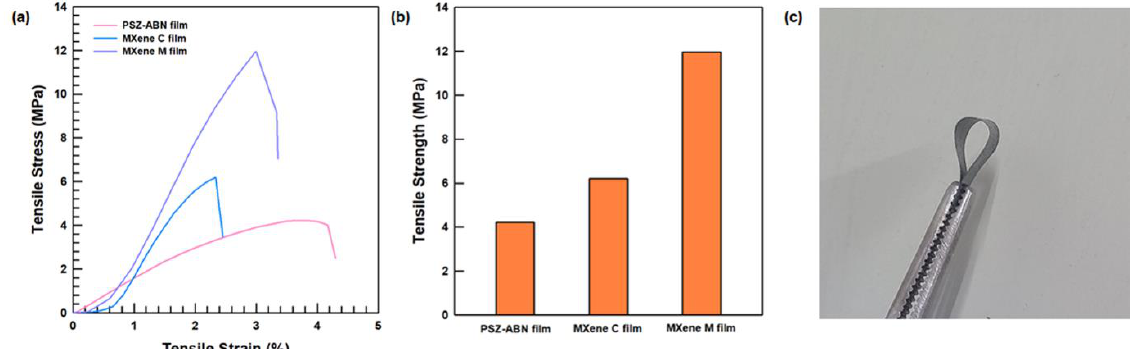
Figure 6. Mechanical properties of the composite films: ( a ) stress–strain curve, ( b ) tensile strength of PSZ-ABN film, MXene-PSZ-ABN (MXene C) film, and MXene/PSZ-ABN/PVA (MXene M) films; ( c ) a digital image of the folded MXene/PSZ-ABN/PVA film.